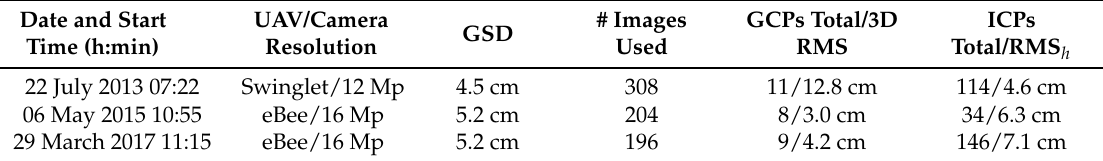
Table 3. Cabedelo sandspit campaigns (2013, 2015, 2017) characteristics and analysis results. UAV: unmanned aerial vehicle; GSD: ground sample